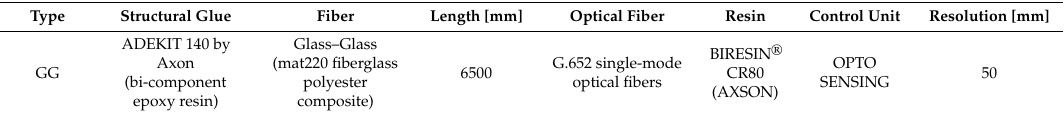
Table 4. second test: transducer parameters. Table 4. Second test: transducer parameters.